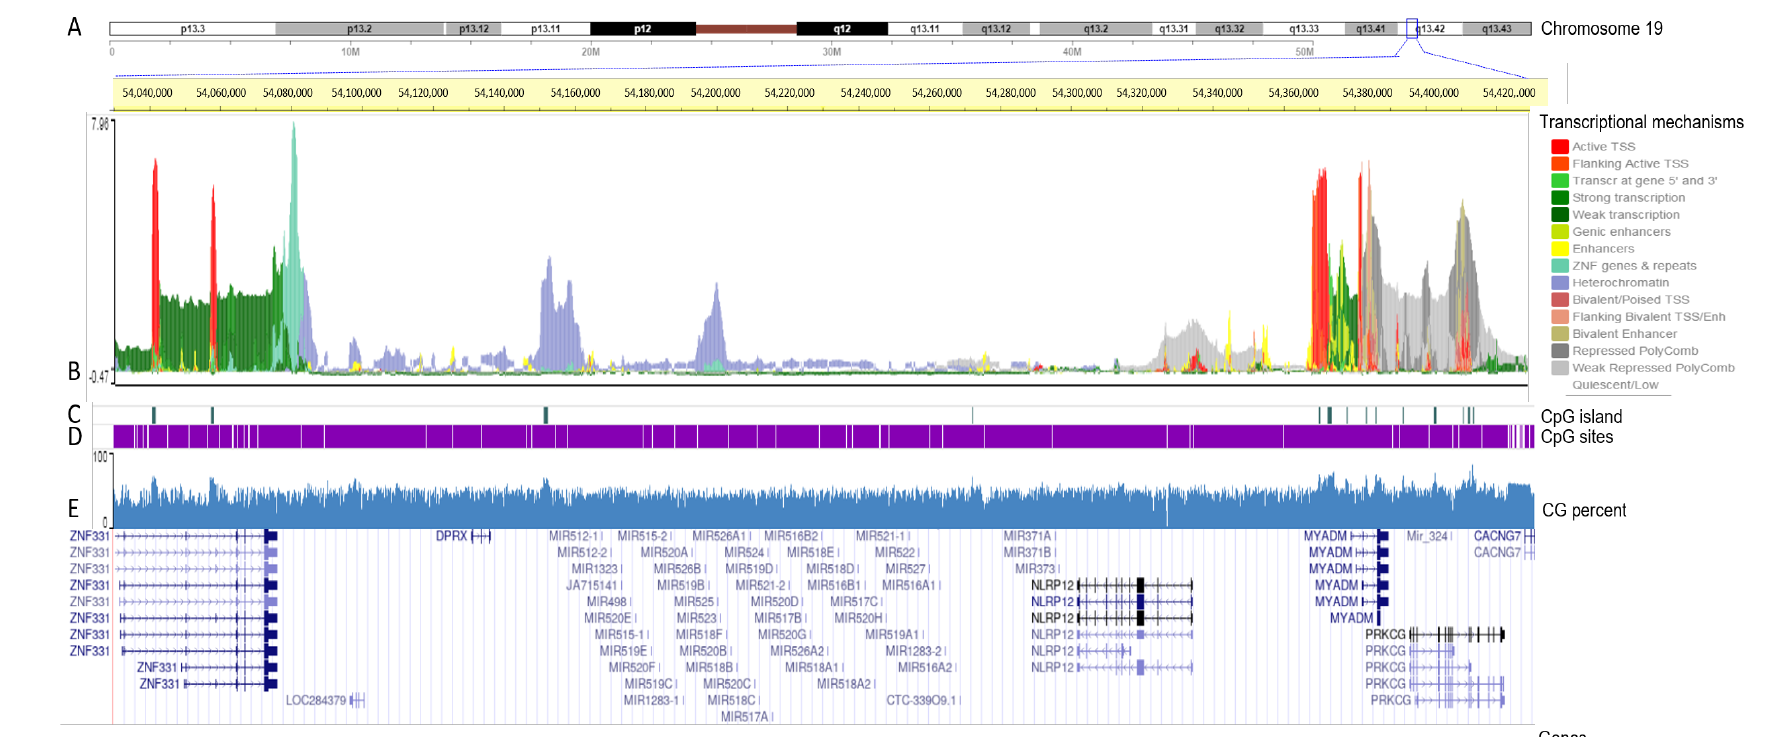
Figure 2. Transcriptional mapping of the C19MC and MIR371-3 clusters on the reference human genome hg19. ( A ) Chromosome 19 ideogram. The C19MC and MIR371-3 clusters are located on 19q13.42. The exact position of the cluster in the region is marked with a blue square. ( B ) Chromosome position. Base pairs of the C19MC and MIR371-3 clusters on chromosome 19 (highlighted in yellow). Transcriptional mechanisms underlying the expression of both clusters, such as transcription start sites (TSS), enhancer regions (Enh), zinc finger (ZNF), packed form of DNA and polycomb group proteins. ( C ) CpG islands in the C19MC and MIR371-3 clusters (green lines). ( D ) Genomic distribution of CpG sites in the C19MC and MIR371-3 clusters (white lines). ( E ) CG percentage in the C19MC and MIR371-3 clusters (blue). Finally, the reference sequences of the members of the C19MC and MIR371-3 cluster are represented at the bottom .